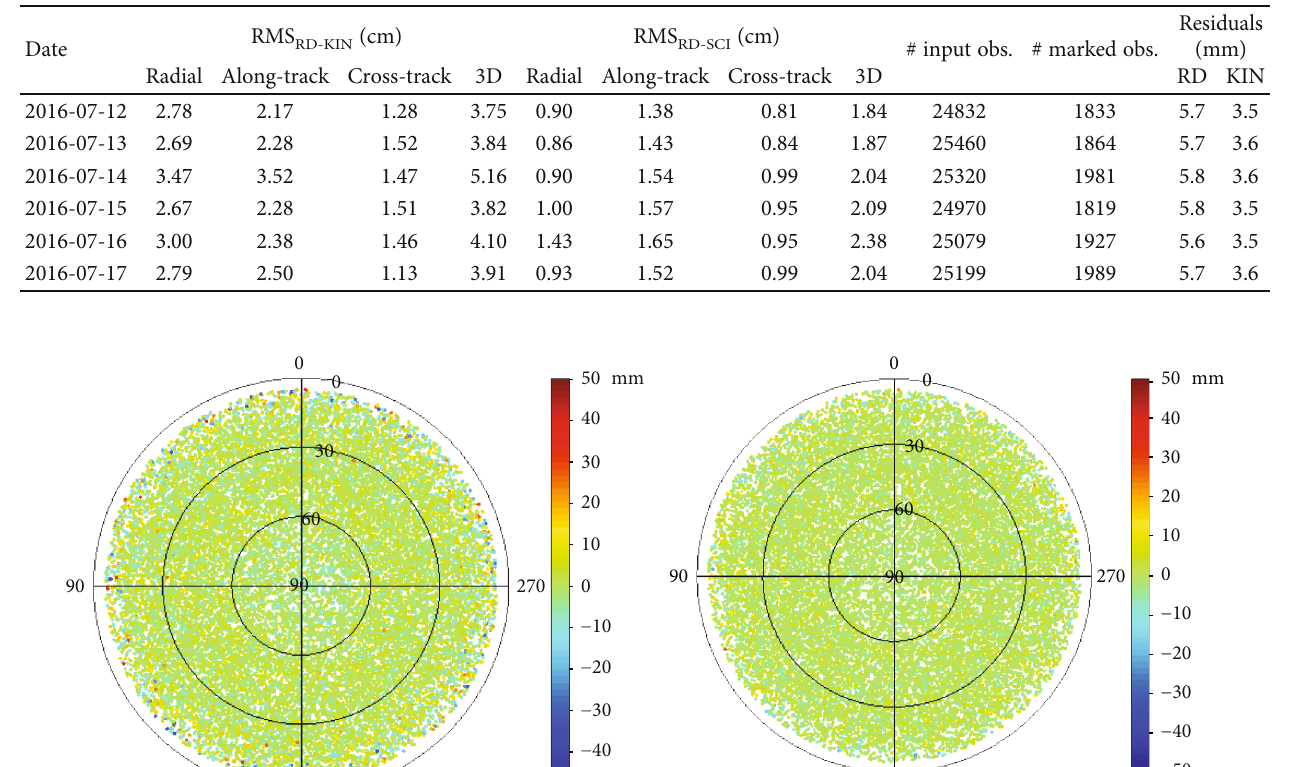
Table 2: Comparison of the precise orbit products for GRACE-A satellite.